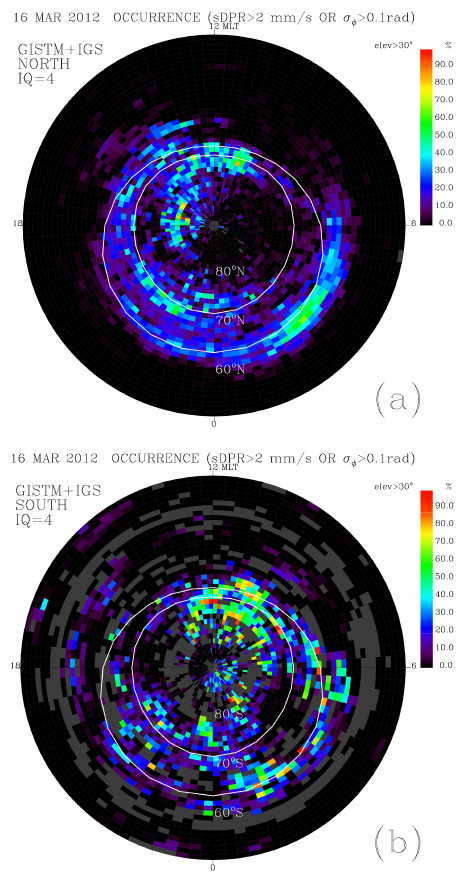
Figure 8. The composite maps of phase scintillation combining the occurrence of sDPR>2mms − 1 and σ (cid:56) >0.1rad in the (a) northern and (b) southern high latitudes on 15 March.